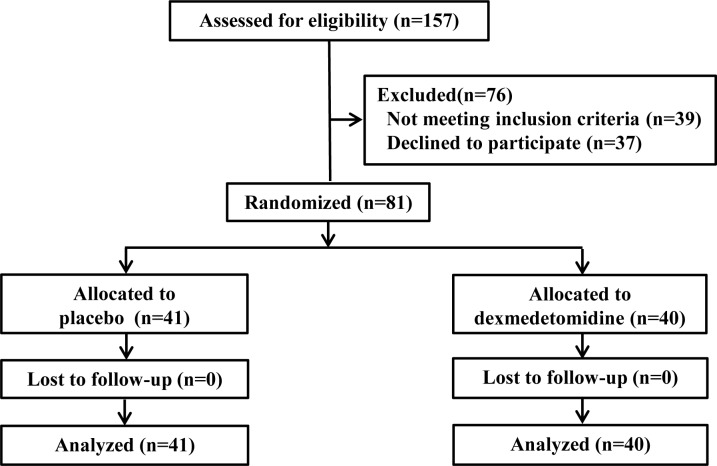
Patient-flow diagram.